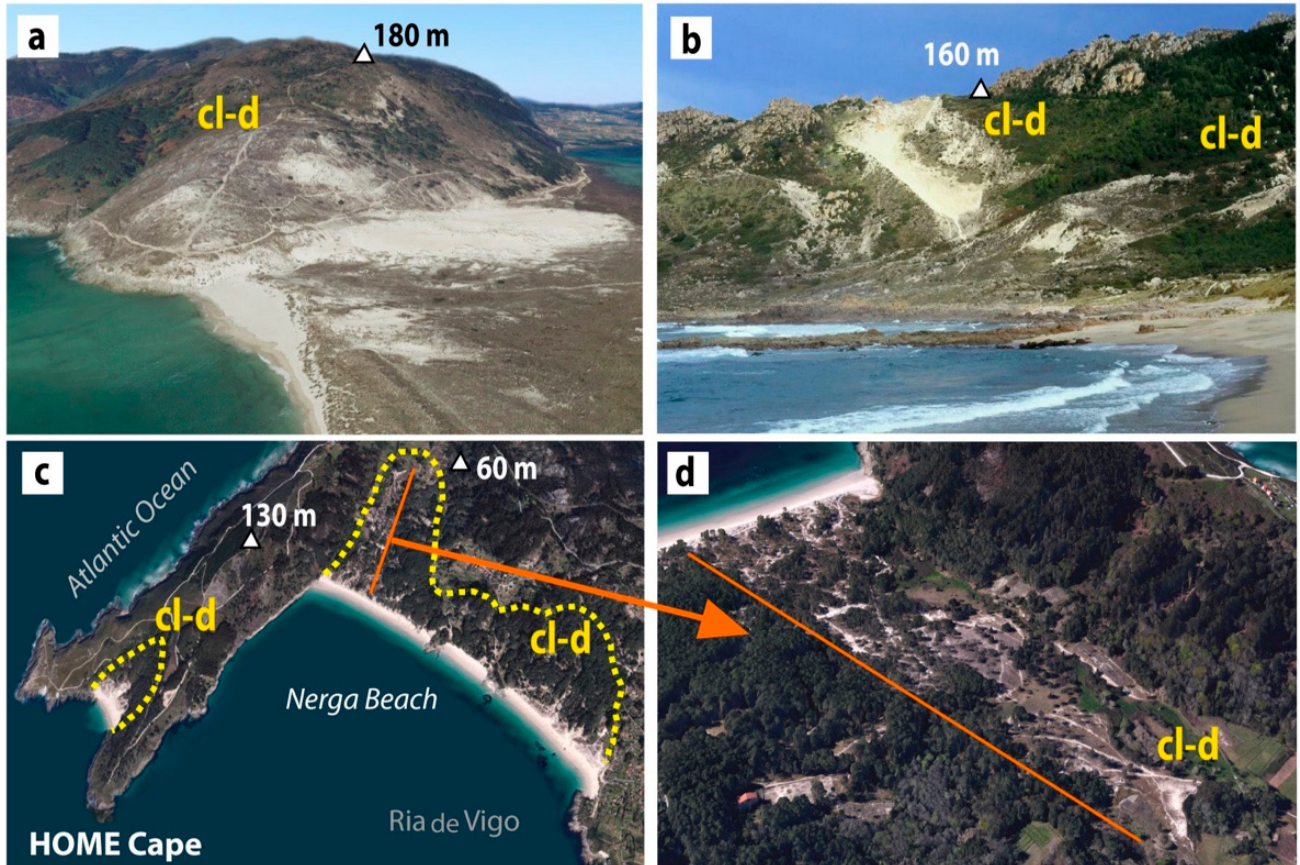
Figure 9. Relict climbing dunes still preserved in the Galician coast, reaching heights of more than 100 m. ( a ) Ponteceso (43°14 ′ 00 ″ N, 8°56 ′ 11 ″ W); ( b ) Trece (43°11 ′ 15 ″ N, 9°08 ′ 45 ″ W). ( c , d ) Relict climbing dunes near the Cíes Islands (northwest coast of the Ria de Vigo). ( c ) Home cape (42°15 ′ 07 ″ N, 8°51 ′ 57 ″ W); the yellow dotted line shows the climbing dune advance. ( d ) Nerga Beach and adjacent climbing dune (42°16 ′ 09 ″ N, 8°51 ′ 15 ″ W) (WGS84); cl ‐ d: climbing dunes.